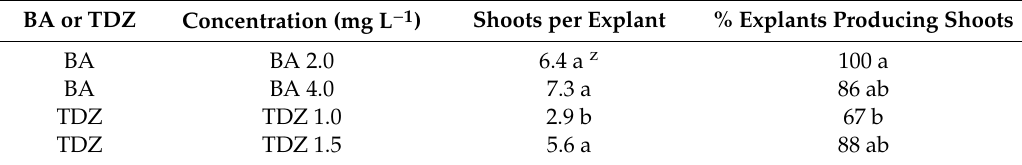
Table 1. E ff ect of 6-benzylaminpurine (BA) and thidiazuron (TDZ) on shoot regeneration from shoot explants of Fragaria vesca . Data were collected 6 weeks after initiating the